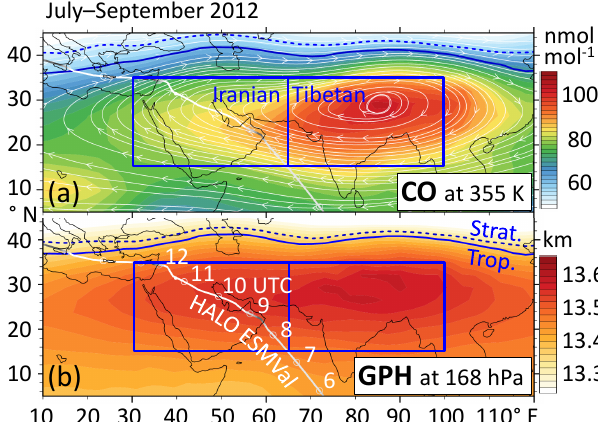
Figure 2. CO mixing ratios and geopotential height (GPH) simu- lated by EMAC for the monsoon months of 2012. Enhanced CO is considered to be a chemical characteristic of the ASMA, and in- creased GPH is a dynamical proxy used to delimit the ASMA. The Iranian and Tibetan domains are used throughout the paper to dis- cuss differences between the convectively driven eastern part and the western part that is mainly controlled by UT transport. The Ira- nian region was traversed by the HALO ESMVal campaign during a flight from Male (Maldives) to Larnaca (Cyprus) on 18 Septem- ber 2012. Beads show the HALO positions at full UTC hours, and the chosen isentropic (a) or pressure (b) levels roughly correspond to UT flight